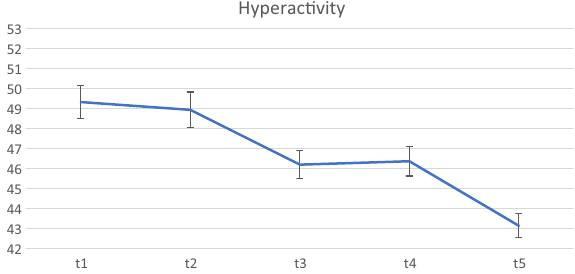
Figure 1. BASC-2 hyperactivity scores from Waitist to 6 month follow-up.